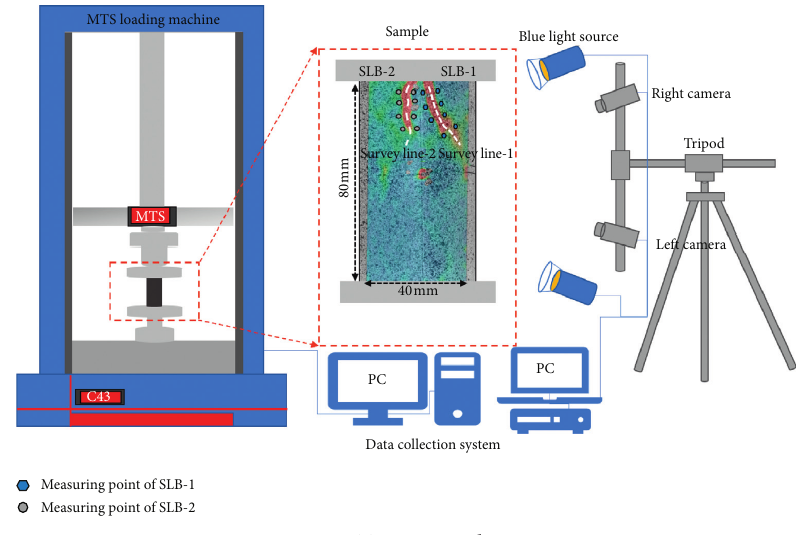
Figure 2: Test system